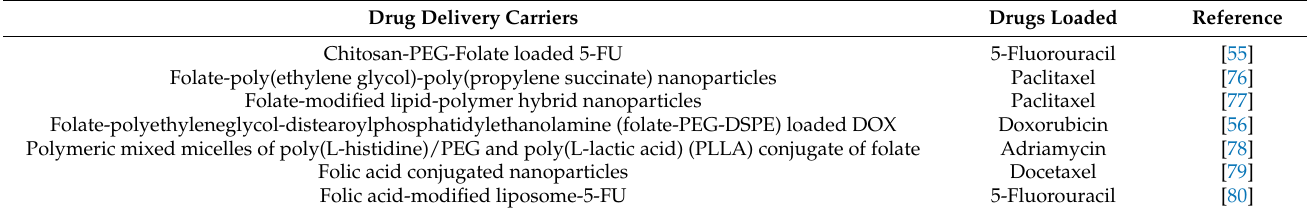
Table 3. Folate-based drug delivery carriers to transport anticancer agents at the targeted tumor lesion. Drug Delivery